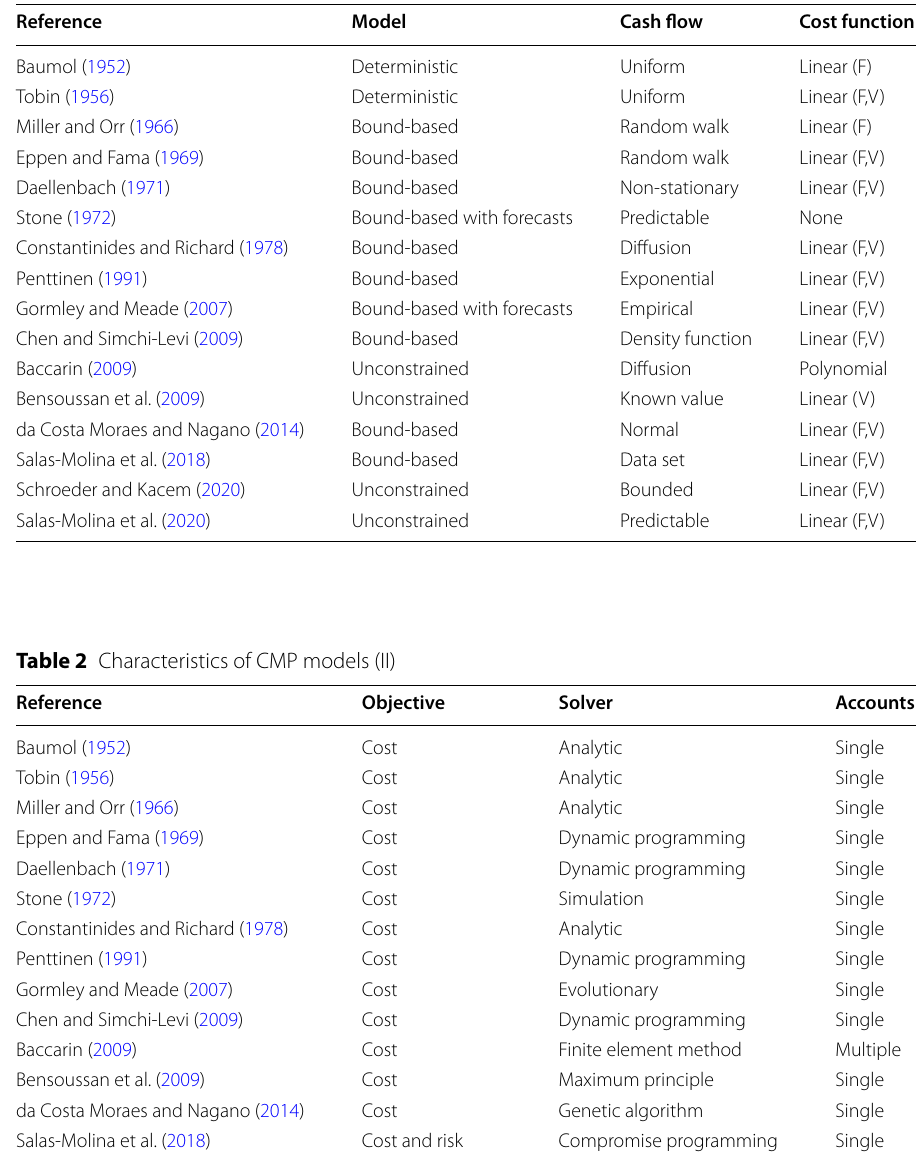
Table 1 Characteristics of CMP models (I). F